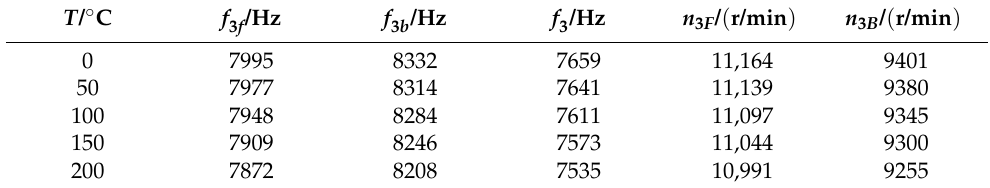
Table 6. TWR speed and frequencies of 3rd predicted by static frequency in different temperatures.